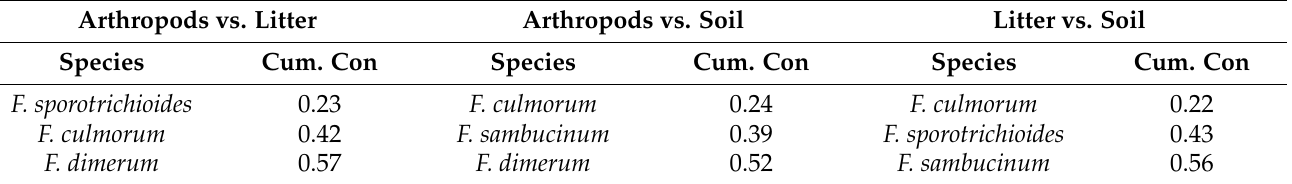
Table 3. Cumulative percentage contribution (Cum. Con. Up to a threshold of 50%) to the difference between communities by the Fusarium species that differentiate most between pairs of substrate types according to similarity percentage